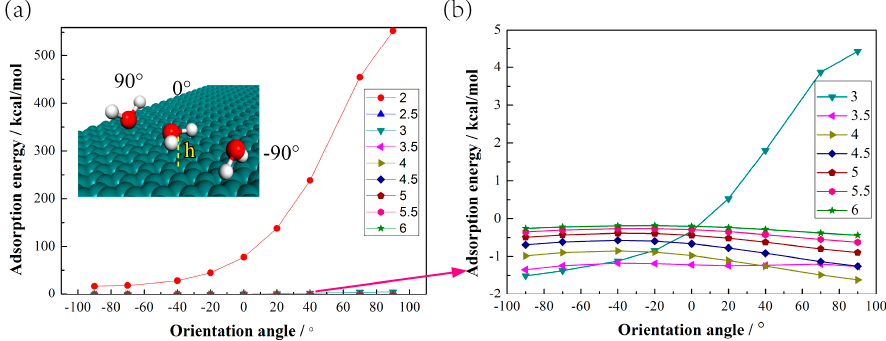
Figure 4. Adsorption energy for a single water molecule. ( a ) Arrangement of single water molecule in adsorption layer on graphite surface and adsorption energy with different distances h and orientation angles; ( b ) Details of adsorption energy for single water molecule for distances larger than 3 Å.